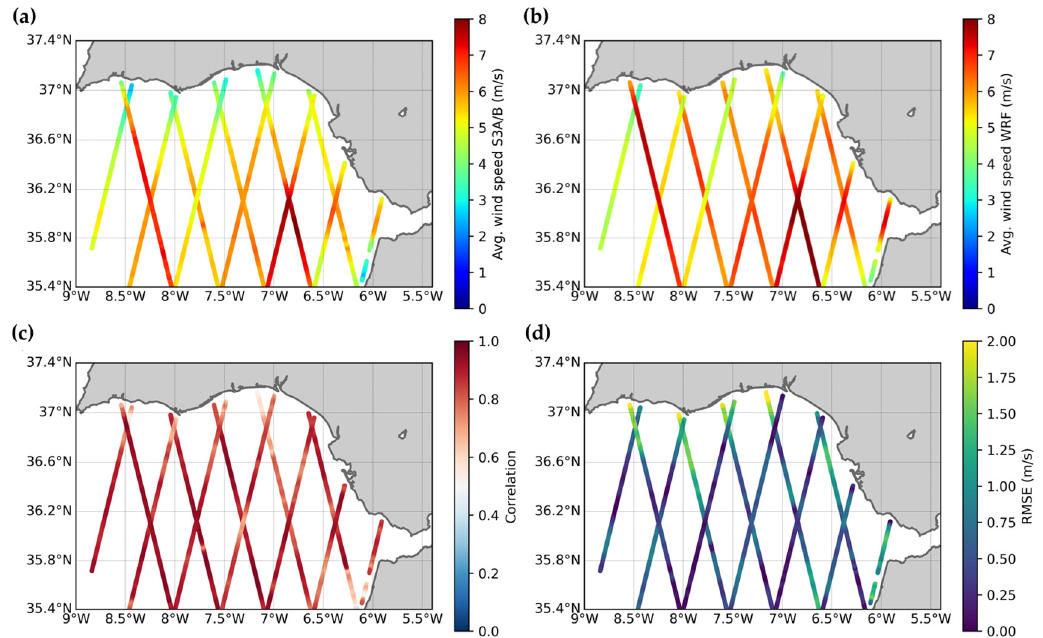
Figure 6. Average WS from S3A/B ( a ) and WRF ( b ); spatial distribution of the r Pearson’s parameter ( c ) and RMSE ( d ) from the comparison among WS data from the WRF model and S3A/B tracks over the study area.